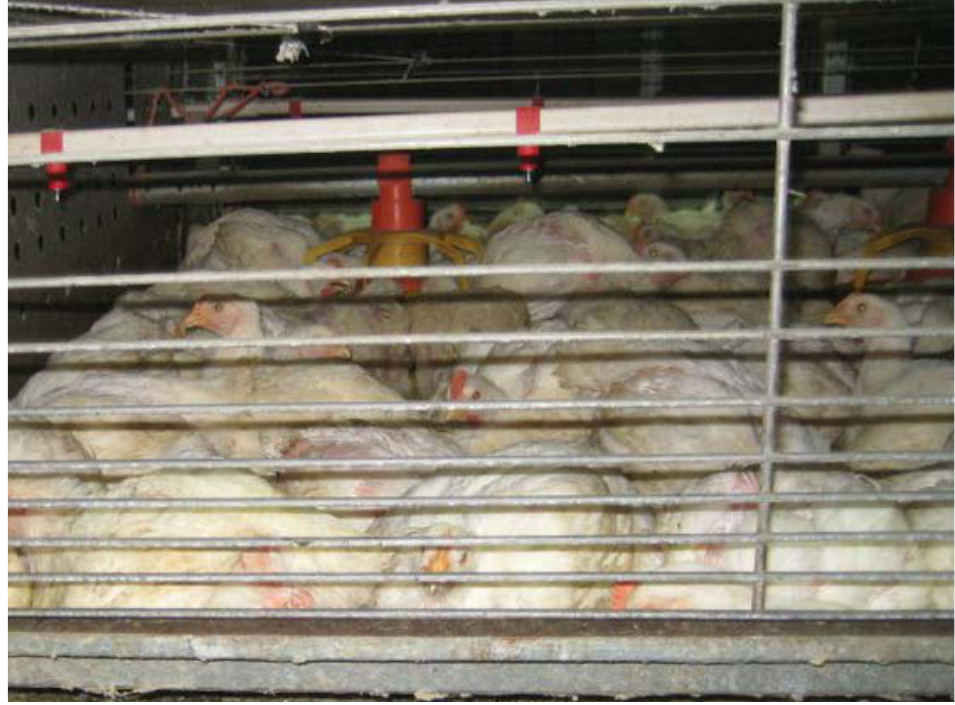
Figure 1. Caged broiler chickens (Photo by Sonia